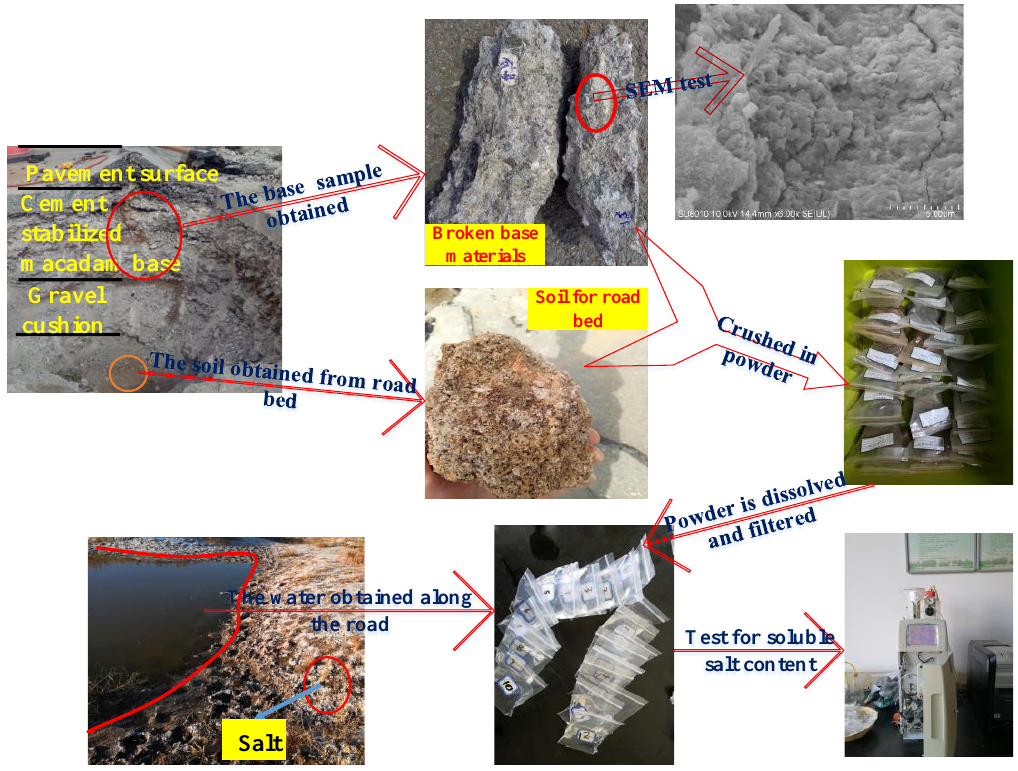
Figure 2. The details of the salt content of the test process.